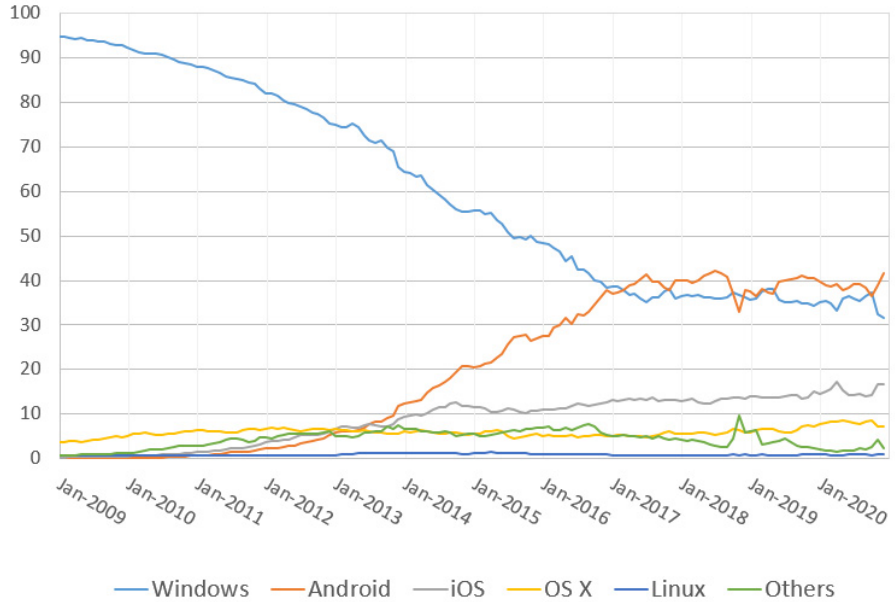
Figure 1. Market share of operating systems worldwide from January 2009 to January 2021 (the graph was developed using data from StatCounter Global Stats [15]).